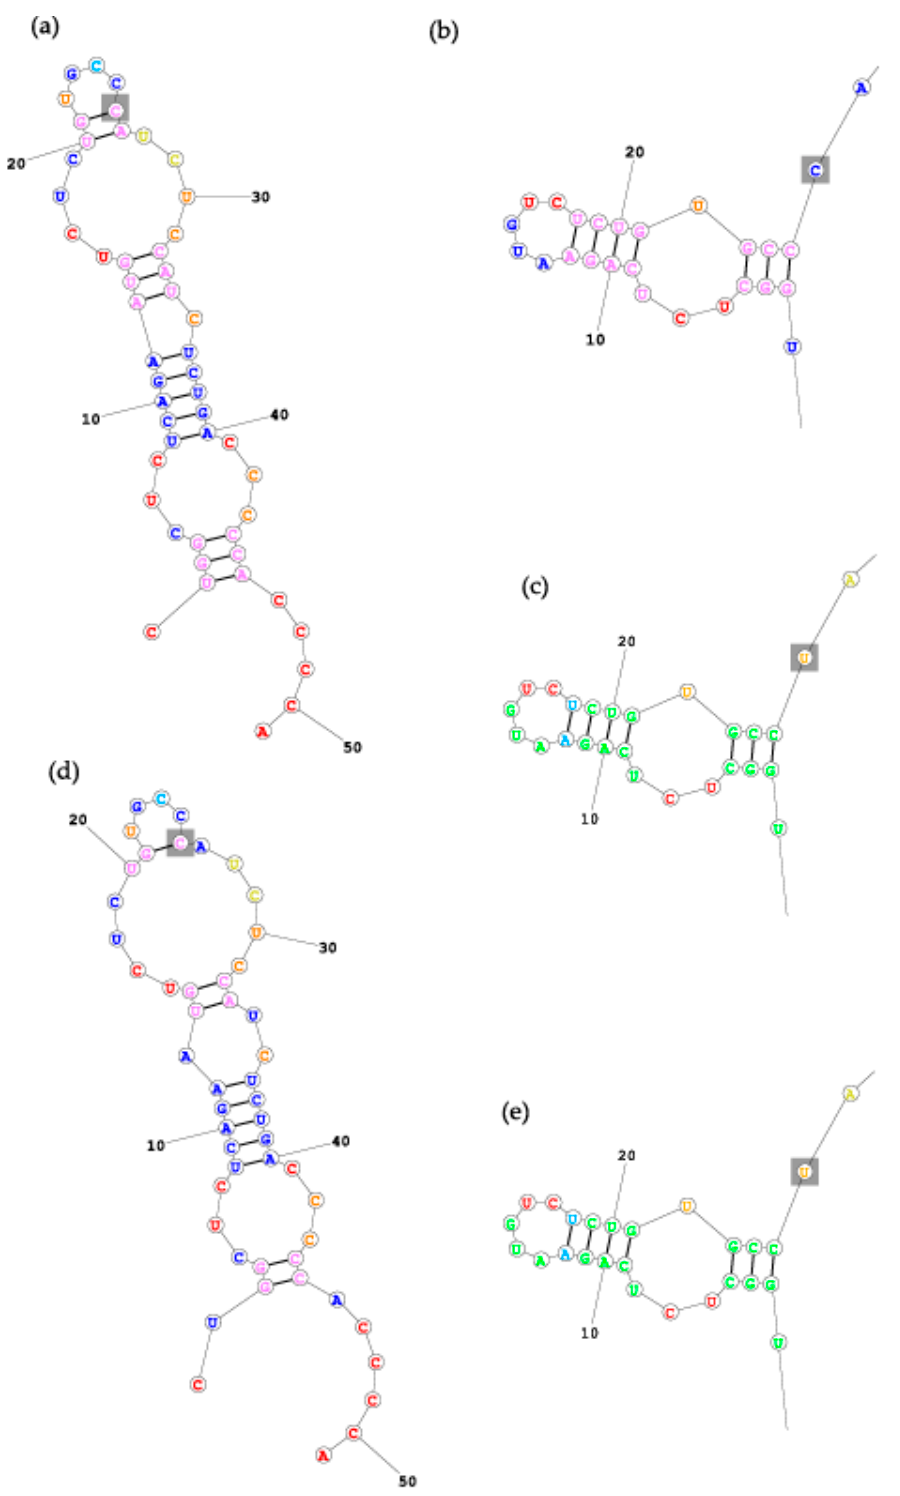
Figure 3. The 2D structures of 51-miR-125a with C-variant ( a , b , d ) and U-variant ( c , e ) predicted by RNAstructure. In grey squares we marked SNPs. ( a ) C-variant MFE model (minimizing free energy), ( b ) C-variant MFE model, and ( c ) U-variant MFE model, ( d ) C-variant MaxExpect model (most probable base-pairing) ( e ) U-variant MaxExpect model. ( b , c , e ) models were cut for better visibility of SNP fragment.